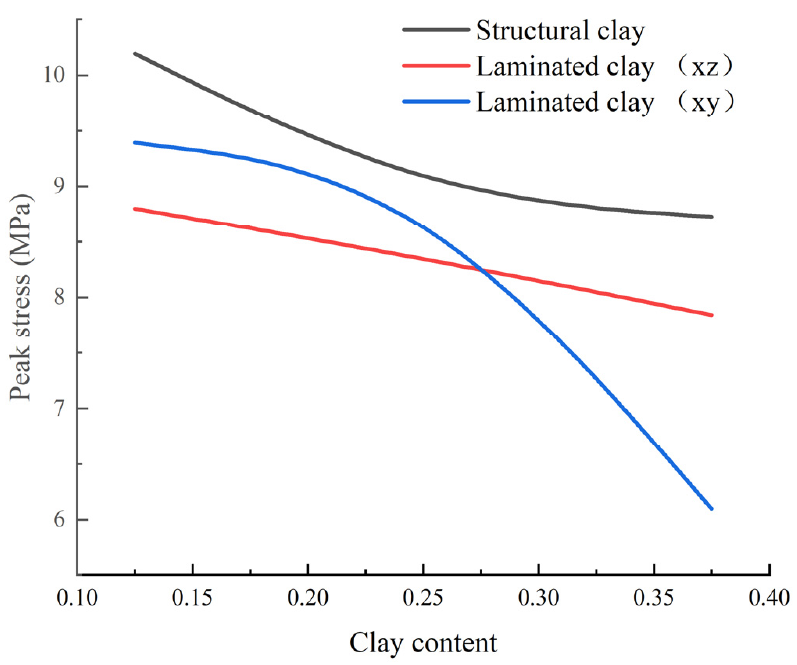
Figure 16. Peak stress vs. content of different clays.